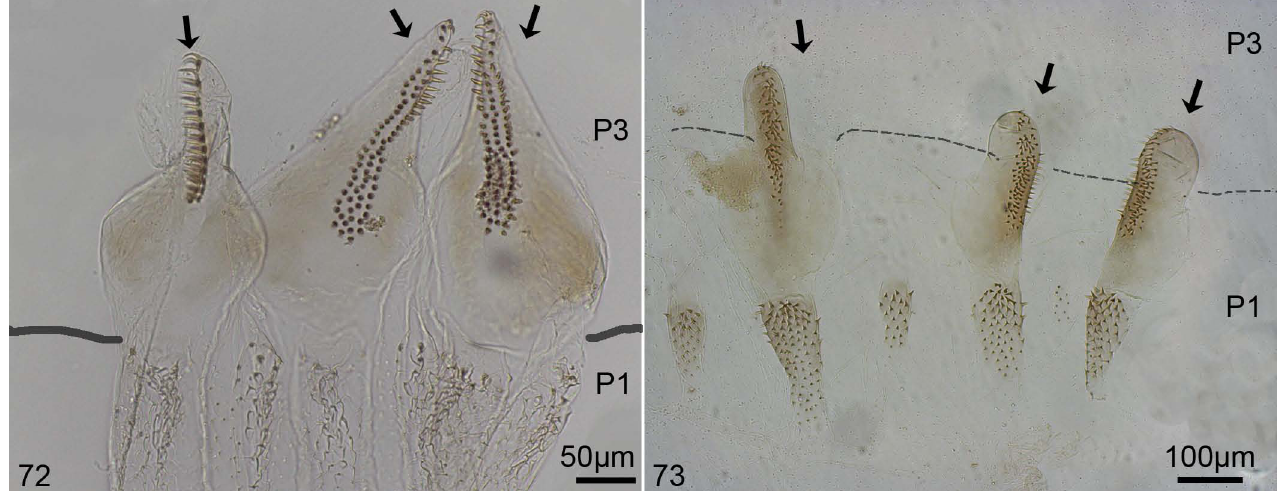
Figs 72–73. Enteric valve armature of: 72- Dentispicotermes conjunctus; 73- Orthognathotermes sp. (arrows: digitiform projections into P3